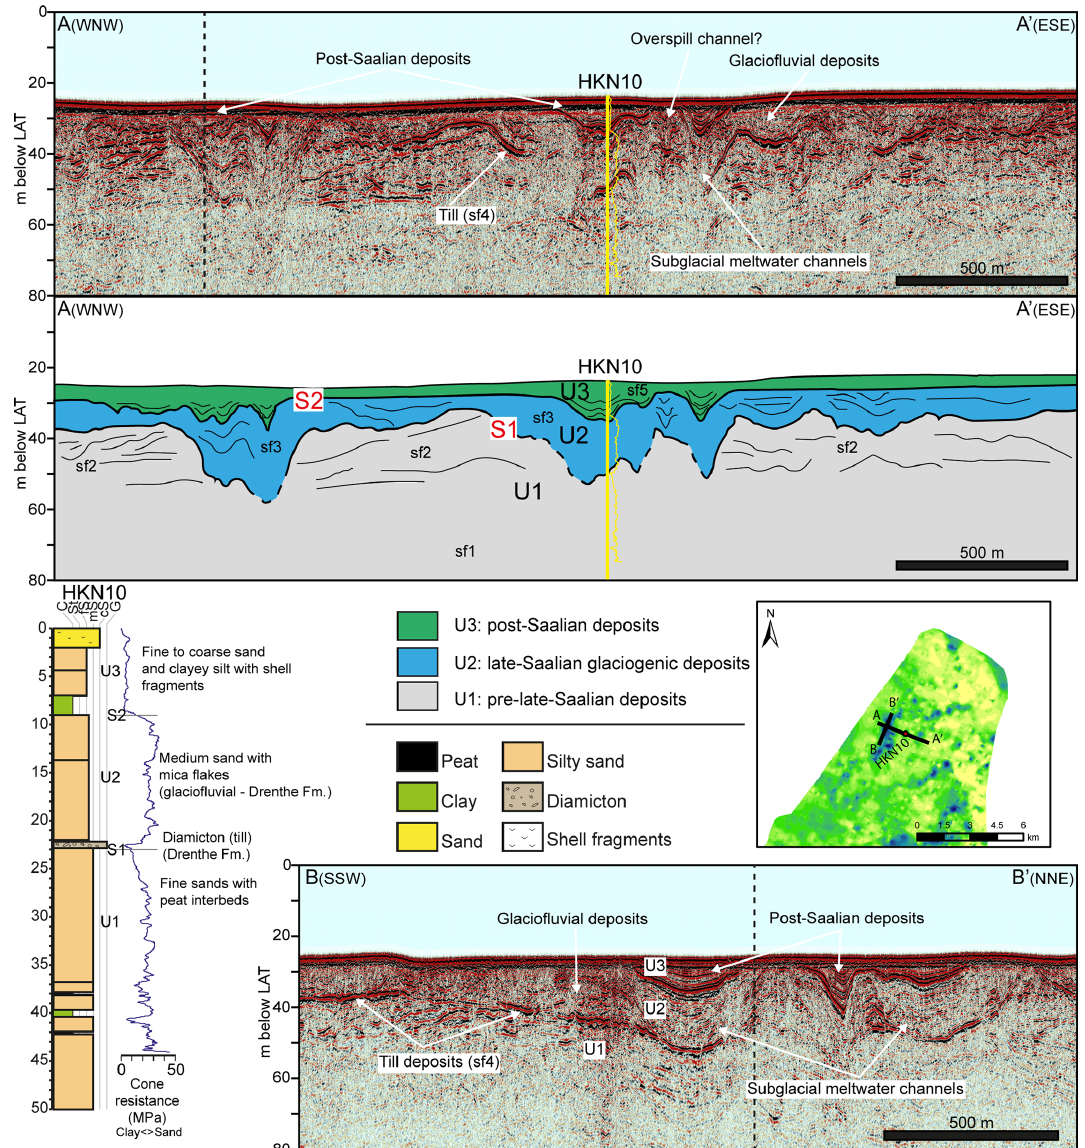
Figure 4. Stratigraphic section (multi-channel sparker) through subglacial meltwater channels in the northern sector of the HKN wind- farm area. Borehole HKN10 was recovered in one of these channels, capturing the sedimentary characteristics of the three main seismic stratigraphic units. Only the upper 50m of the borehole is shown. Cone resistance from a CPT obtained at the same site is displayed on the side of the borehole and in the seismic profiles. For the location of the seismic profiles and the borehole see the inset map (same map from Fig. 3). Grain sizes – C: clay, St: silt, fS: fine sand, mS: medium sand, cS: coarse sand, G: gravel. The vertical dashed line indicates the position at which the seismic profiles cross each